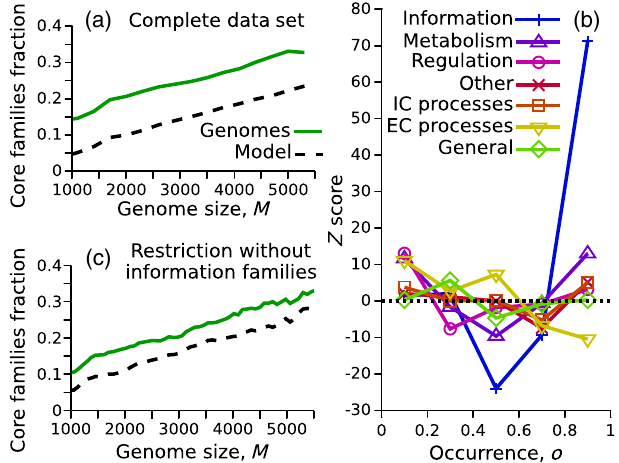
FIG. 7. Specific functional constraints can be detected by deviations from the predictions of a random sampling. (a) Fraction of common protein domain families as a function of the genome sizes. Each point of the curves corresponds to the core families ( o > θ c ¼ 0 . 95 ) given the occurrence distribution of a genome ’ s subset whose sizes are inside a certain window. The average size of the genomes within the size window defines the x axis. (b) Enrichment analysis in the occurrence distribution for specific functional categories. Considering domain families relative to a single functional category, their relative component occurrence distribution was evaluated for an ensemble of systems built with a random sampling. From this, the average value and the standard deviation for the expected fraction of components at each occurrence value o can be calculated. This provides a measure ( Z score) of over- or underrepresentation of domain families belonging to each functional category in the empirical data set. IC and EC denote intra-cellular and extra-cellular processes respec- tively. (c) Excluding from the analysis the domain families associated to information processes (i.e., DNA replication, tran- scription, and translation) significantly reduces the offset between the random-sampling prediction and the empirical